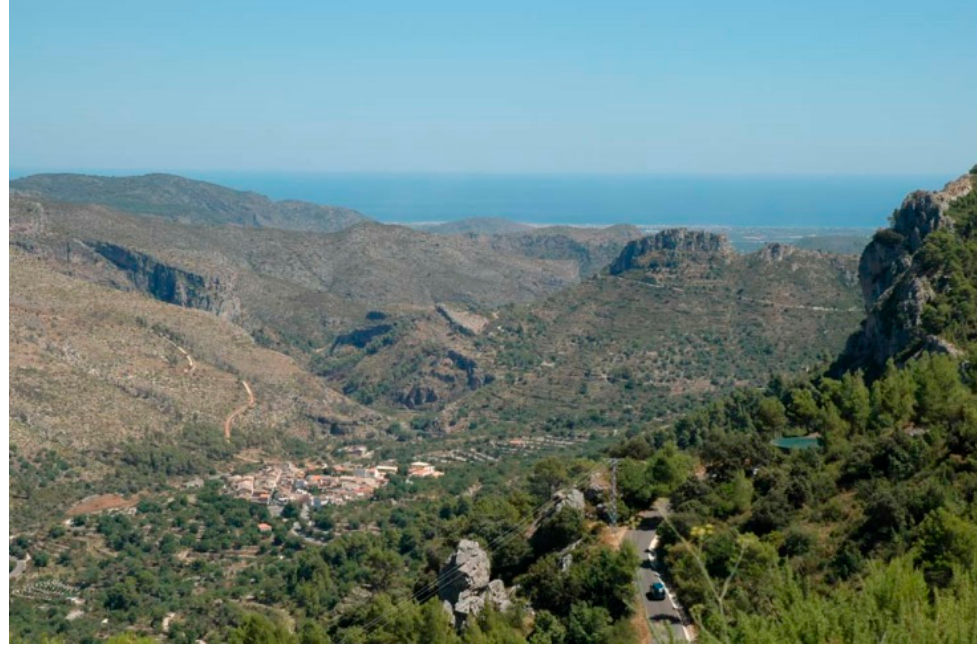
Figure 1. The natural and human landscape in Vall de Gallinera.